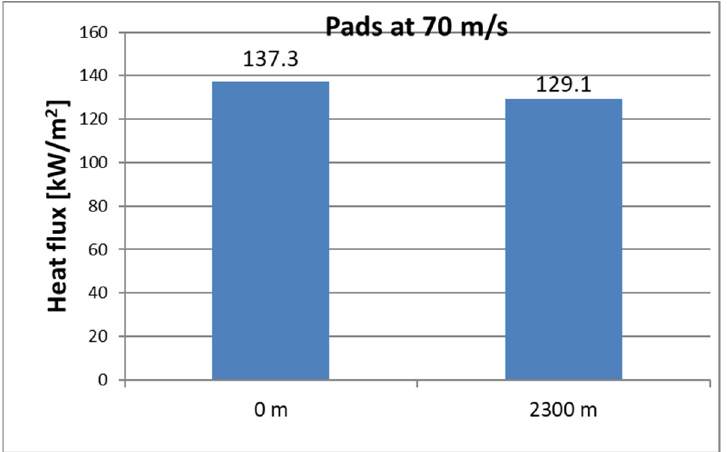
Figure 22. Comparison of heat dissipation values from the pads at different altitudes—coupled heat transfer case at 70 m/s.